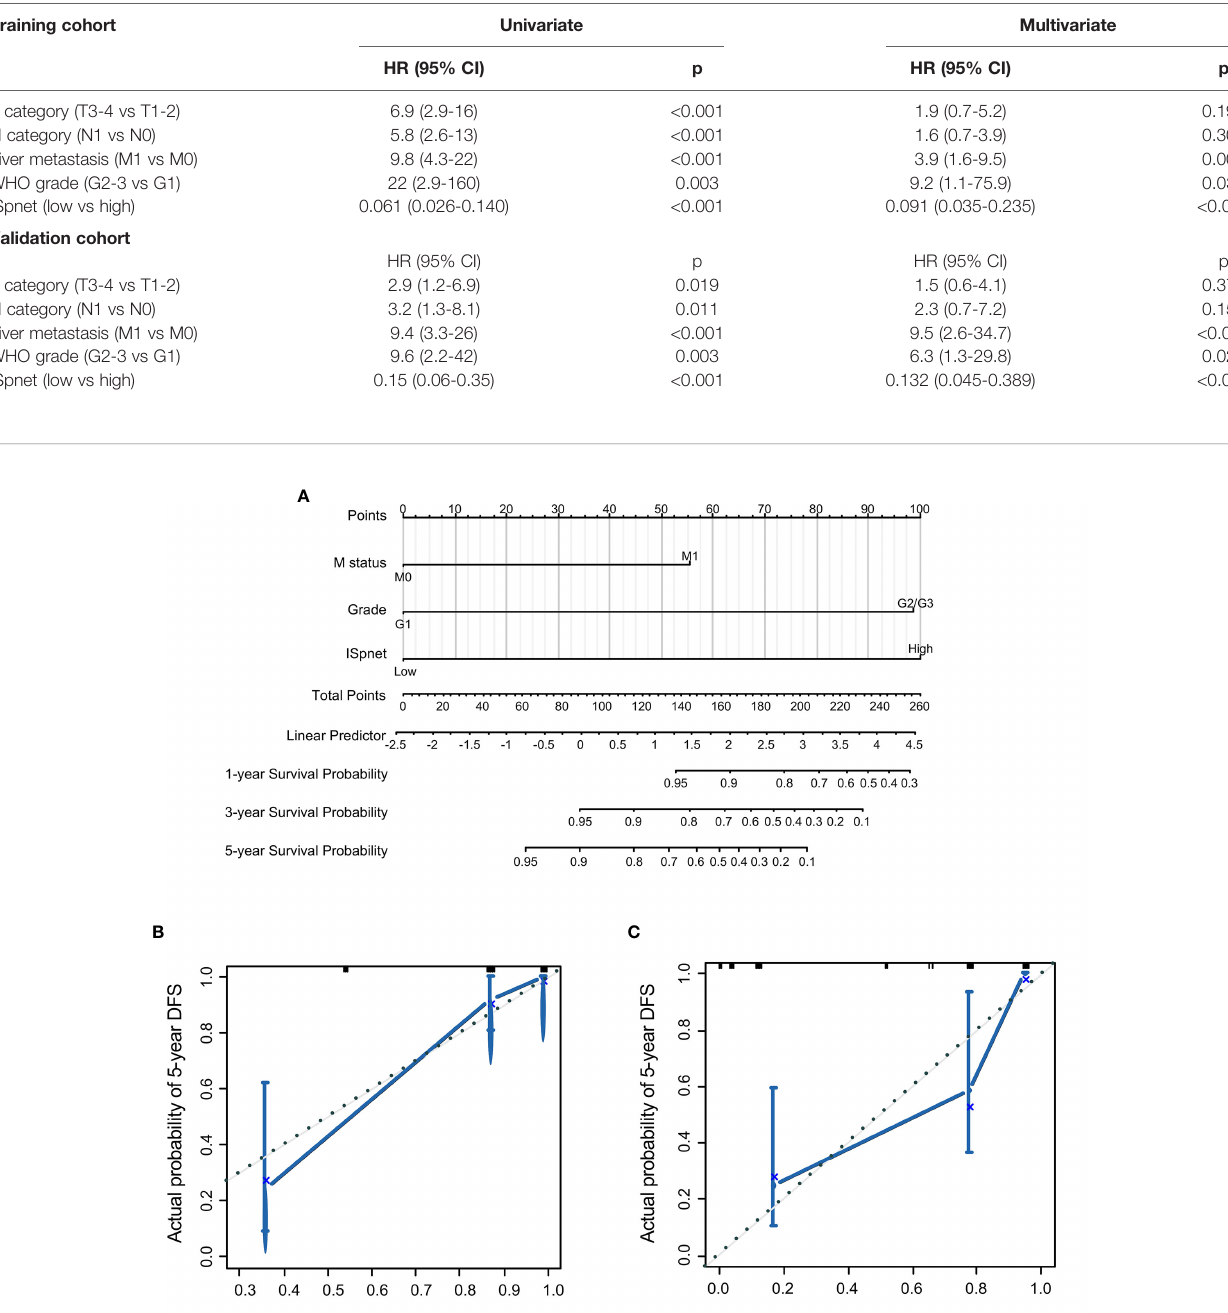
TABLE 3 | Univariate and multivariate Cox regression analysis of prognostic factors in the training and validation cohorts.